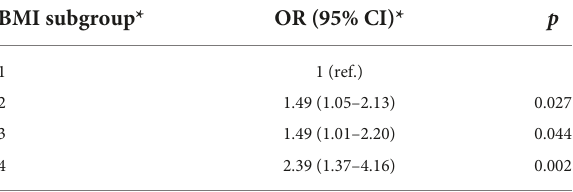
TABLE 3 Association of A β positivity with BMI